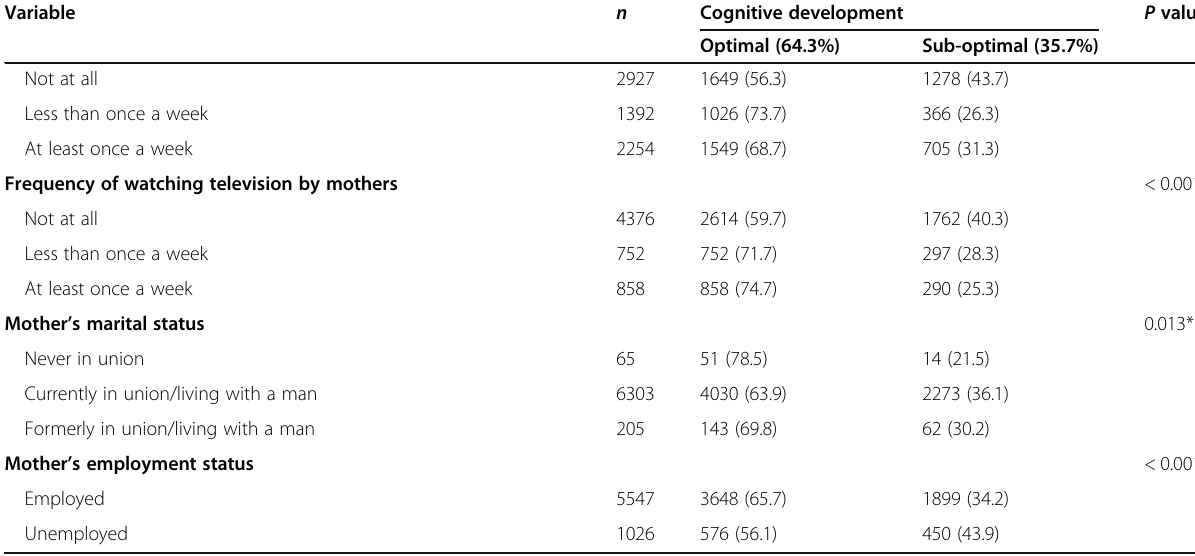
Table 1 The factors associated with under-five cognitive development using Chi-square test (Continued) Variable